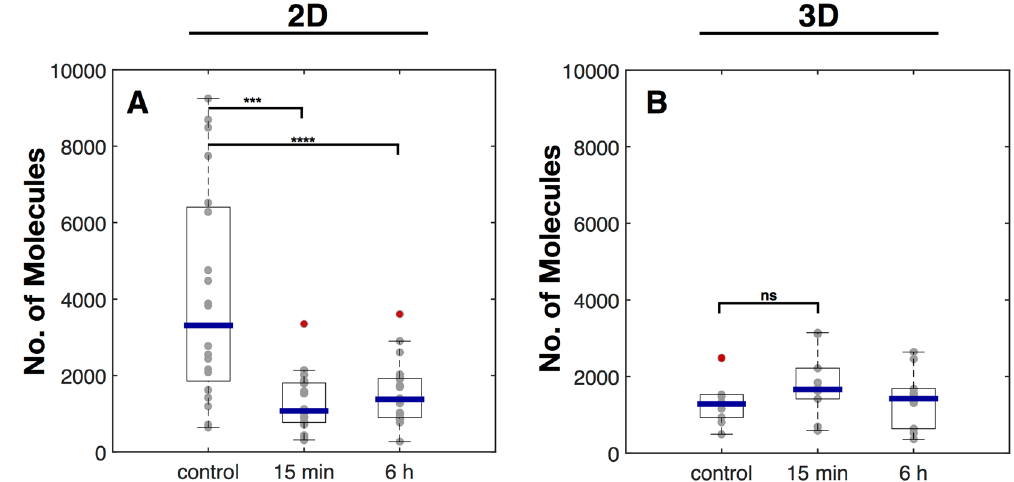
Figure 6. Effects of IR on pFAK of 2D and 3D cultured MEF cells. Box plots of the number of molecules per 4 × 4 µ m ROI of cells cultured in 2D ( A ) and 3D ( B ). Cells were irradiated with 6 Gy and were fixed 15 min and 6 h after irradiation. For 2D cells N = 2 and n = 20, for 3D cells N = 2 and n = 10. Statistical analysis was performed with an ordinary one-way ANOVA. *** p ≤ 0.001 and **** p ≤ 0.0001. NS, not significantly different. If not further noted no significance was